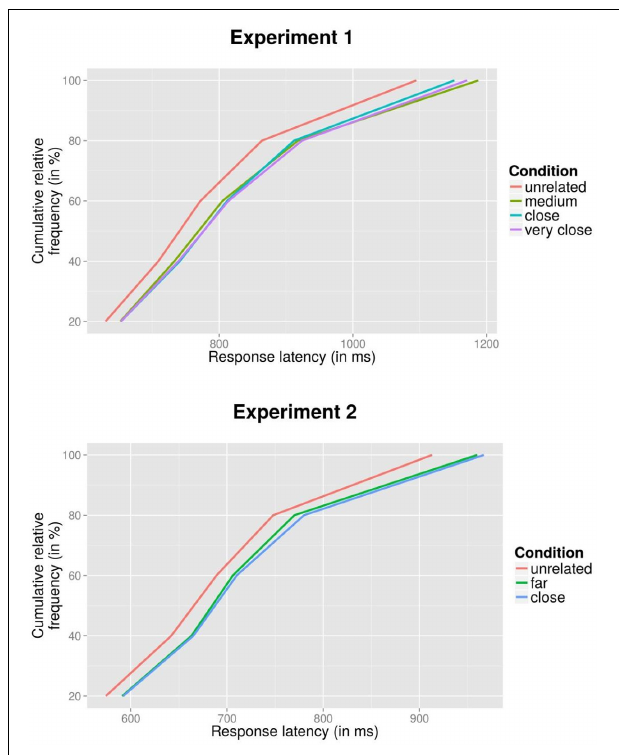
FIGURE 1 | Vincentized cumulative distribution curves for Experiment 1 (top panel) and Experiment 2 (bottom